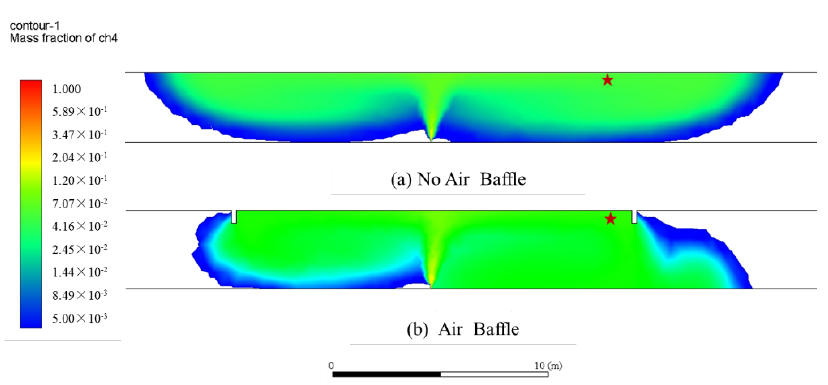
Figure 8. Under the condition of no wind, the dangerous area of the gas cabin with ( a ) No Air Baffle and ( b ) Air Baffle, when the gas leakage continues for 10s.